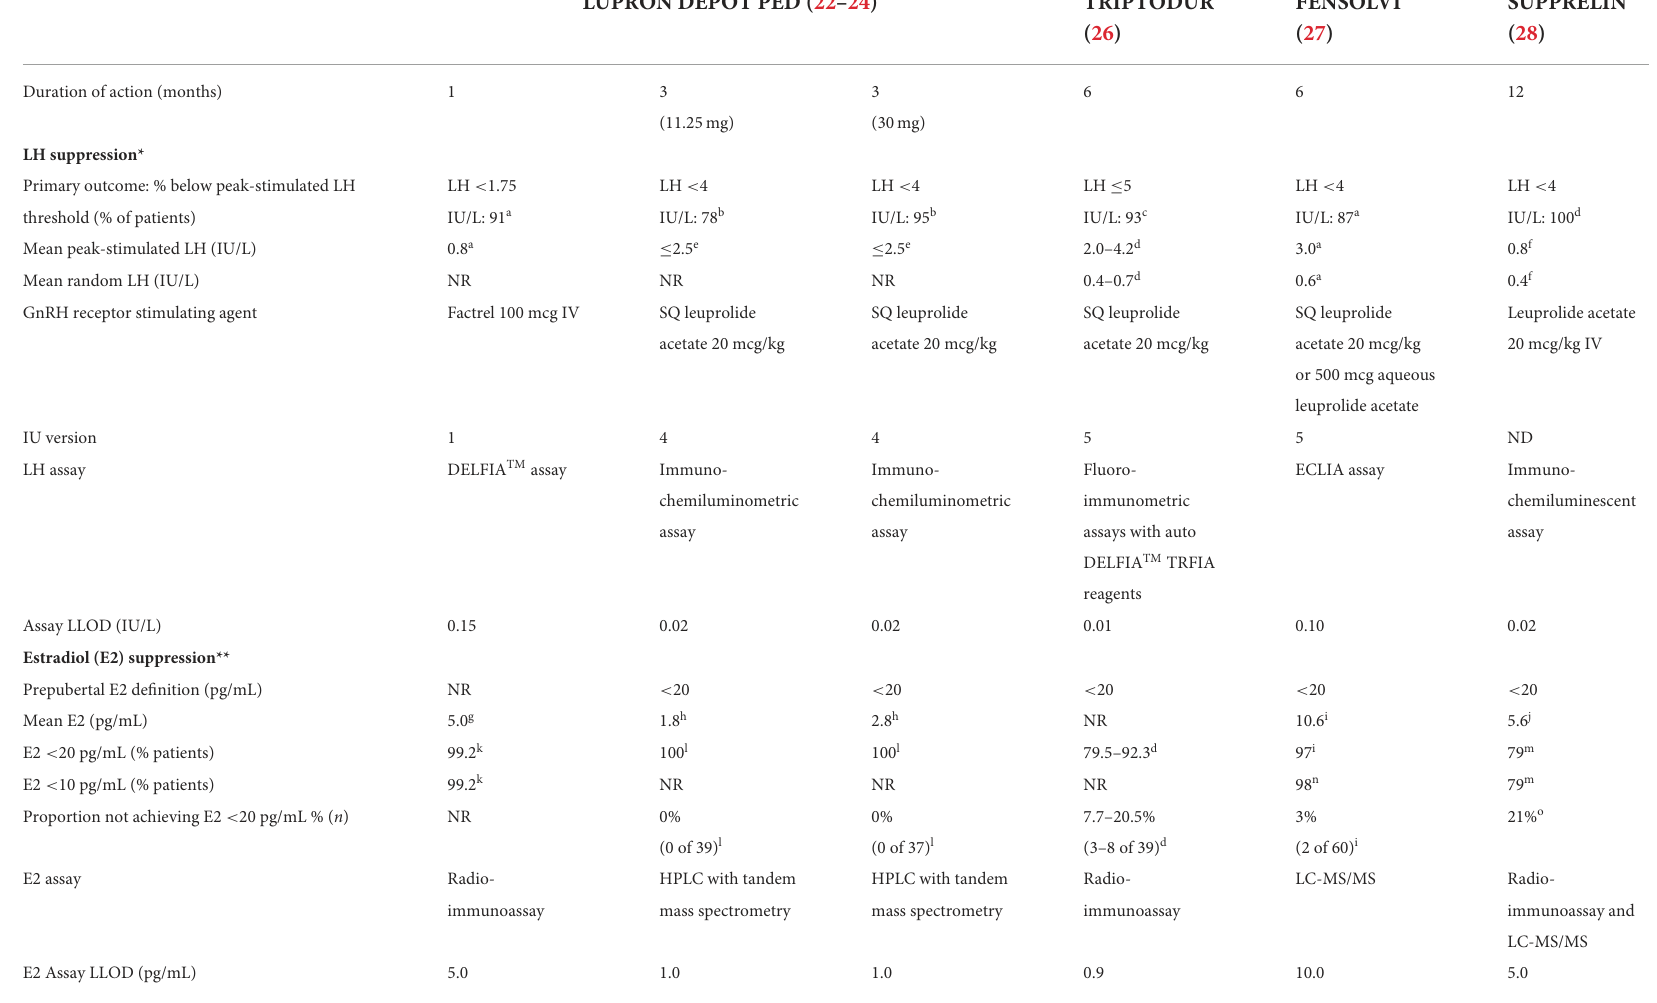
TABLE 2 Biochemical and clinical pubertal suppression from pivotal trials of CPP therapies (approved in